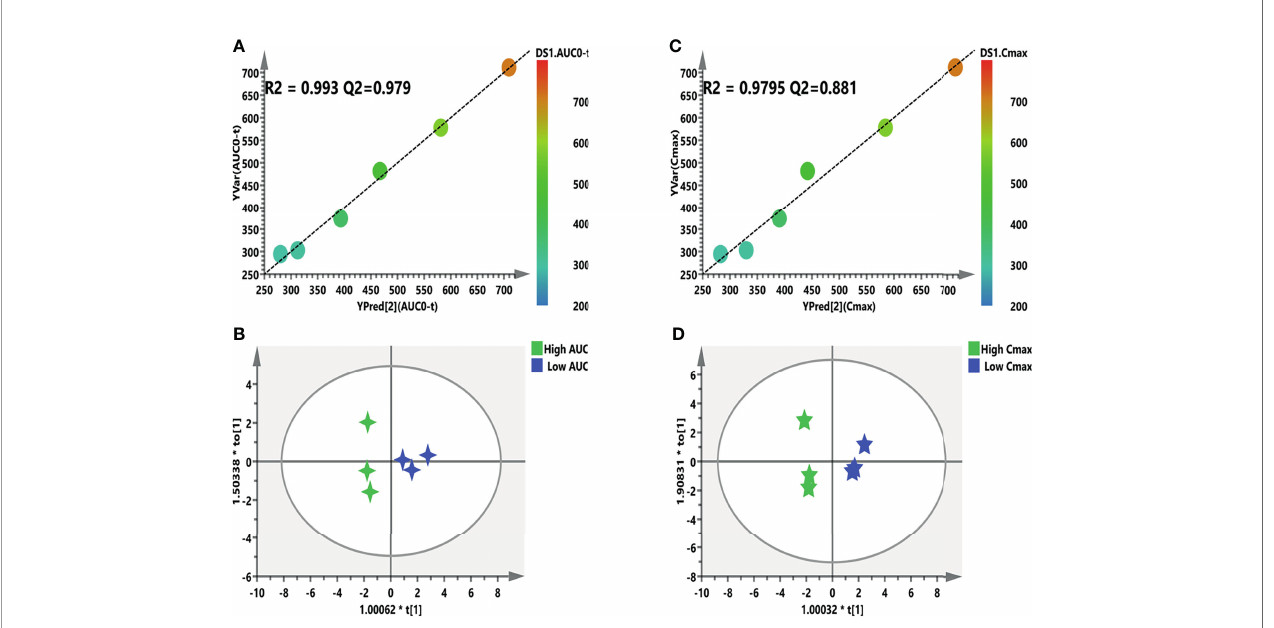
FIGURE 8 | Re fi ned models predicting the individualized pharmacokinetic (PK) parameters based on the screened biomarkers. (A , C) Regression plots of the predicted vs. the measured PK parameters (AUC or C max ). Color from blue to red indicates the corresponding PK values from low to high. (B , D) Orthogonal projection to latent structures discriminant analysis (OPLS-DA) models discriminating the subgroups based on the screened biomarkers. AUC , area under the curve; C max , maximum